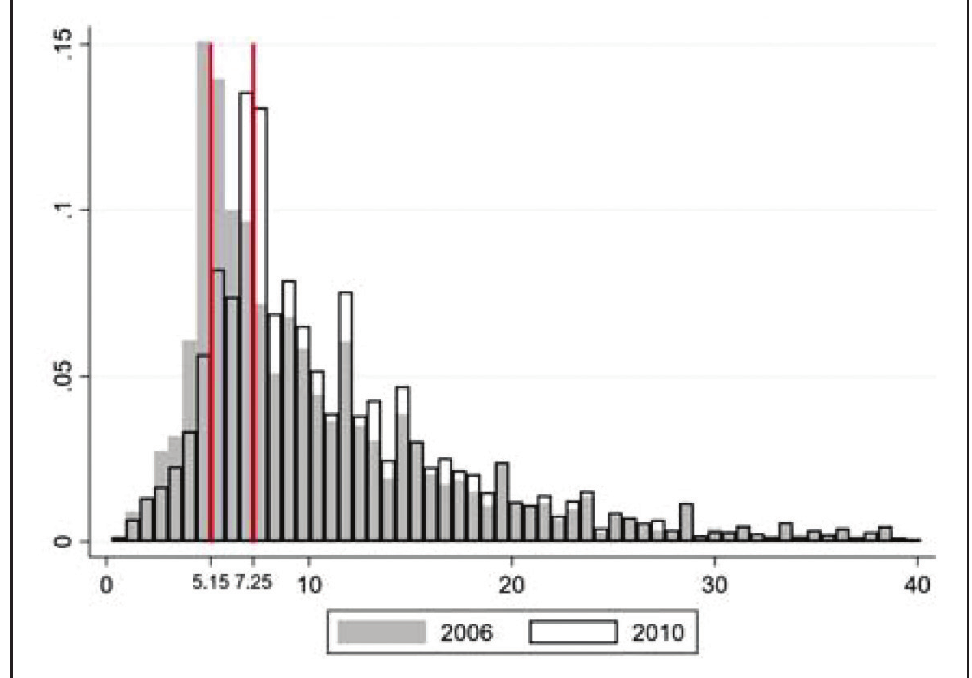
Figure 1 Distribution of Wages in Puerto Rico in 2006 and 2010.